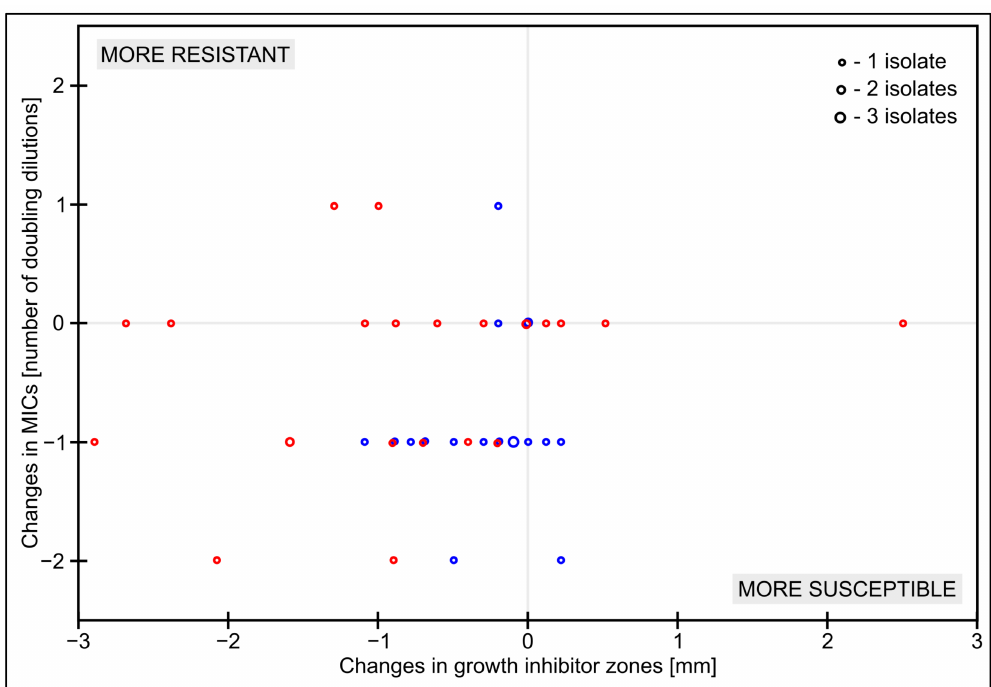
Figure 3. Scatterplot of changes in MICs and inhibition diameter zones depending on the source of the substance tested (blue—tablet 1, red—tablet 2) against the reference method with pure